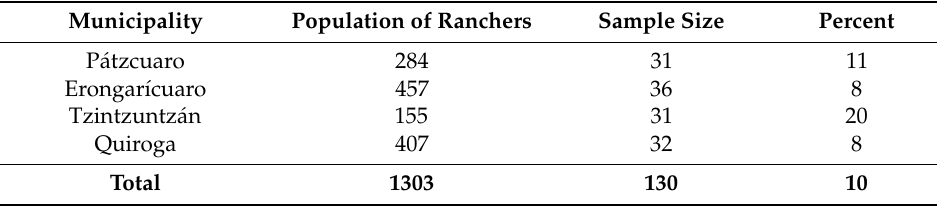
Table 1. Case Study